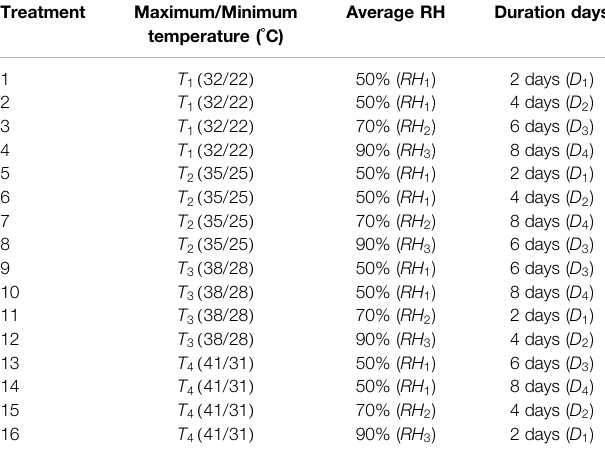
TABLE 3 | Orthogonal experimental design